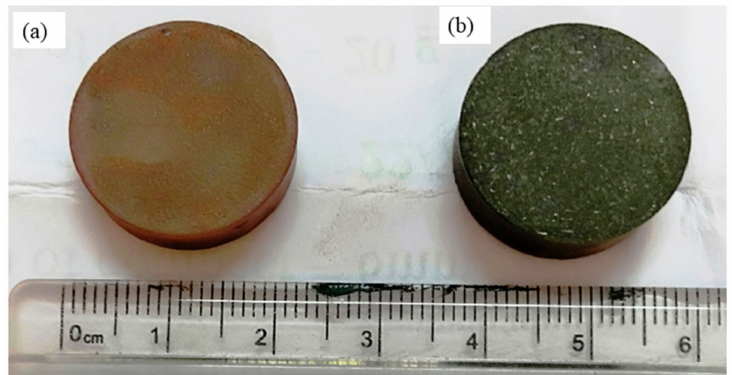
Figure 1. Real images of the samples ( a ) after cold compaction; ( b ) after heat